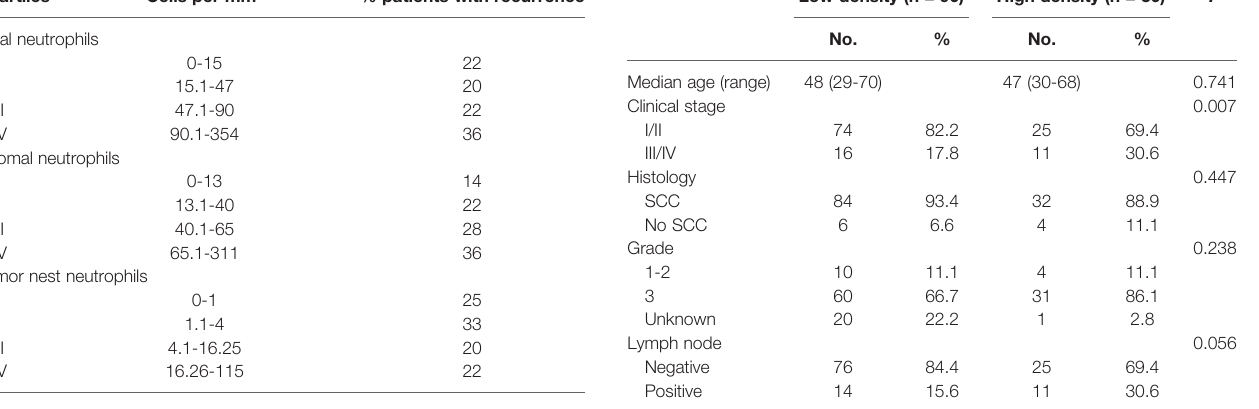
TABLE 2 | Percentage of patients with recurrence within 5 years from diagnosis strati fi ed by CD66b + neutrophil cell density quartiles. Quartiles Cells per mm 2 % patients with recurrence